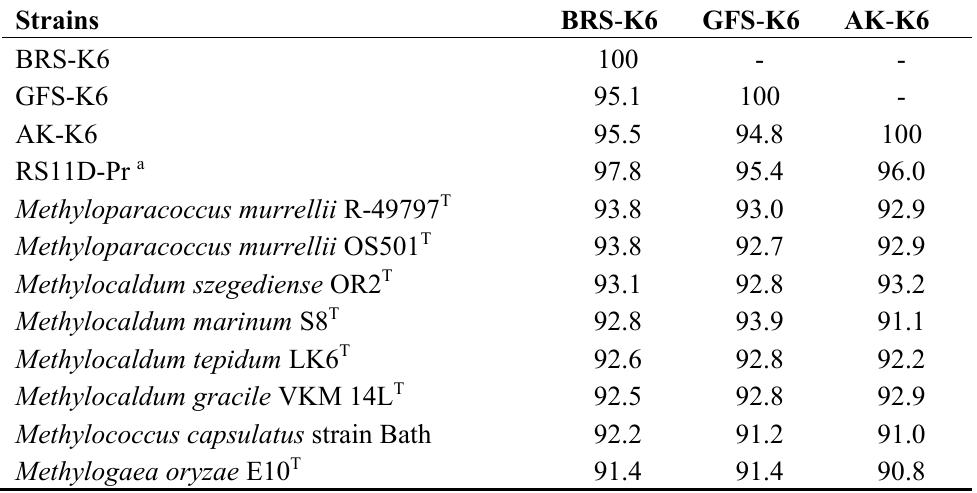
Table 1. Pairwise sequence alignment analysis of 16S rRNA sequences shows identity between BRS-K6, GFS-K6, AK-K6 and other related methane-oxidizing bacteria (MOB) [38]. Values are given as a